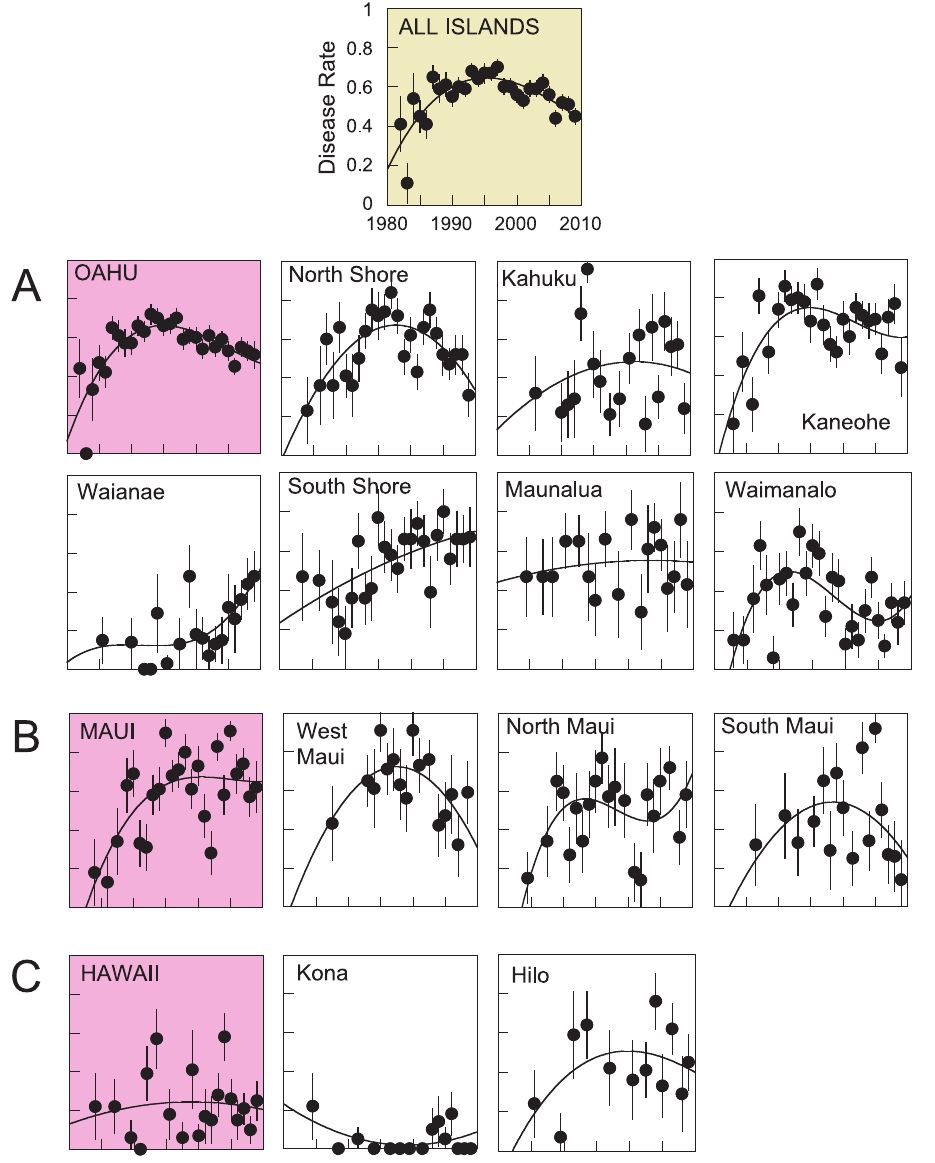
Figure 3. Time series of standardized disease rates show significant regional variability and suggest a local cause. All islands series (yellow plot) indicates the disease peaked - at this scale - in the mid 1990s and gradually declined thereafter. A , Oahu series (pink plot) is similar to the all islands trend, but regions within differ dramatically. Some Oahu regions (Waianae and South Shore) continue to increase today. Similar results are obtained for B , Maui and C , Hawaii. Trend line is the highest ranked quadratic model fit. Grouping data in space and time will likely mask important information related to the cause and impact of this disease.